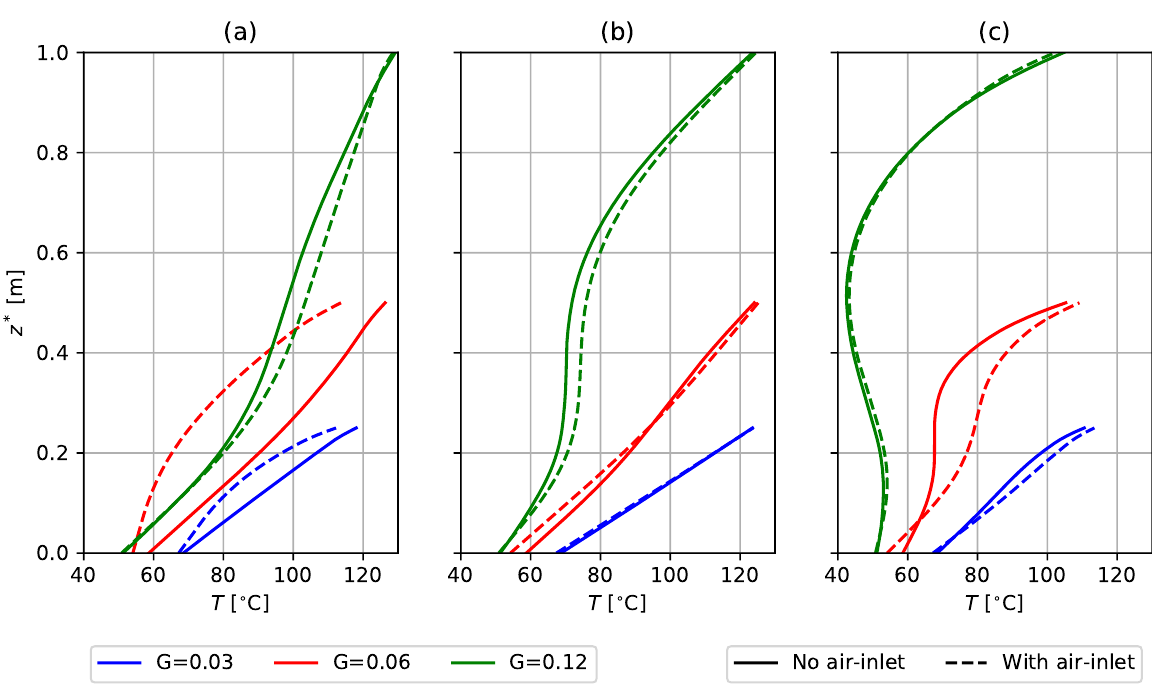
Figure 20. Temperature profile in the axial direction for r ∗ = r / R ( a ) 0.52, ( b ) 0.73, and ( c ) 0.93. The normalized gap-length equals z ∗ = z / d max , where z ∗ = 0 corresponds to the